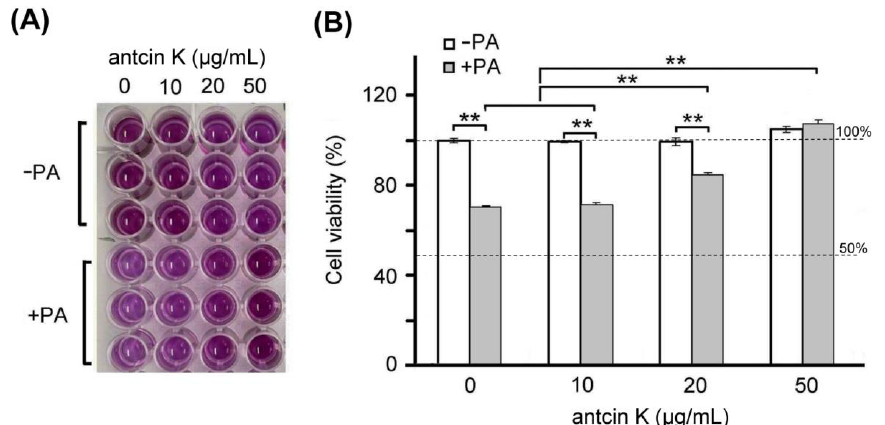
Figure 4. Antcin K treatments effectively alleviated cell viability of palm oil-treated vascular en- dothelial cells. ( A ) MTT assay showed the cell viability of vascular endothelial cells under different concentrations (0, 10, 20, and 50 µ g/mL) of antcin K treatments. ( B ) Comparison of the quantified cell viability among vascular endothelial cells with and without 0.75 mM palm acid oil (PA) treatment and with antcin K treatments at 0, 10, 20, and 50 µ g/mL. In this experiment, IC 50 cell viability of vascular endothelial cells for antcin K treatment was much larger than 50 µ g/mL. ( n = 3 for each group; values are presented as mean ± SEM, ** p < 0.01, two-way ANOVA followed by the Student–Newman–Keuls multiple comparison post hoc